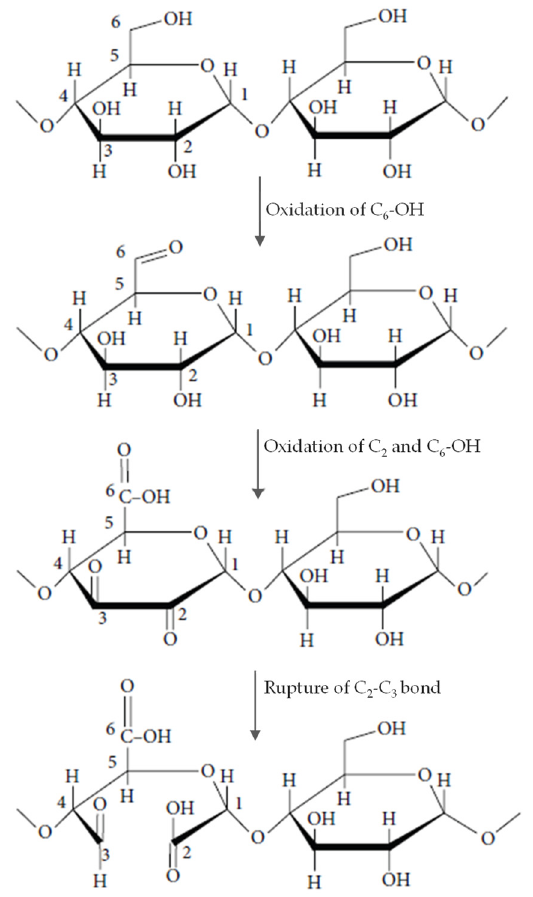
Figure 3. Schematic diagram of carbonyl and hydroxyl groups formed in starch oxidation.